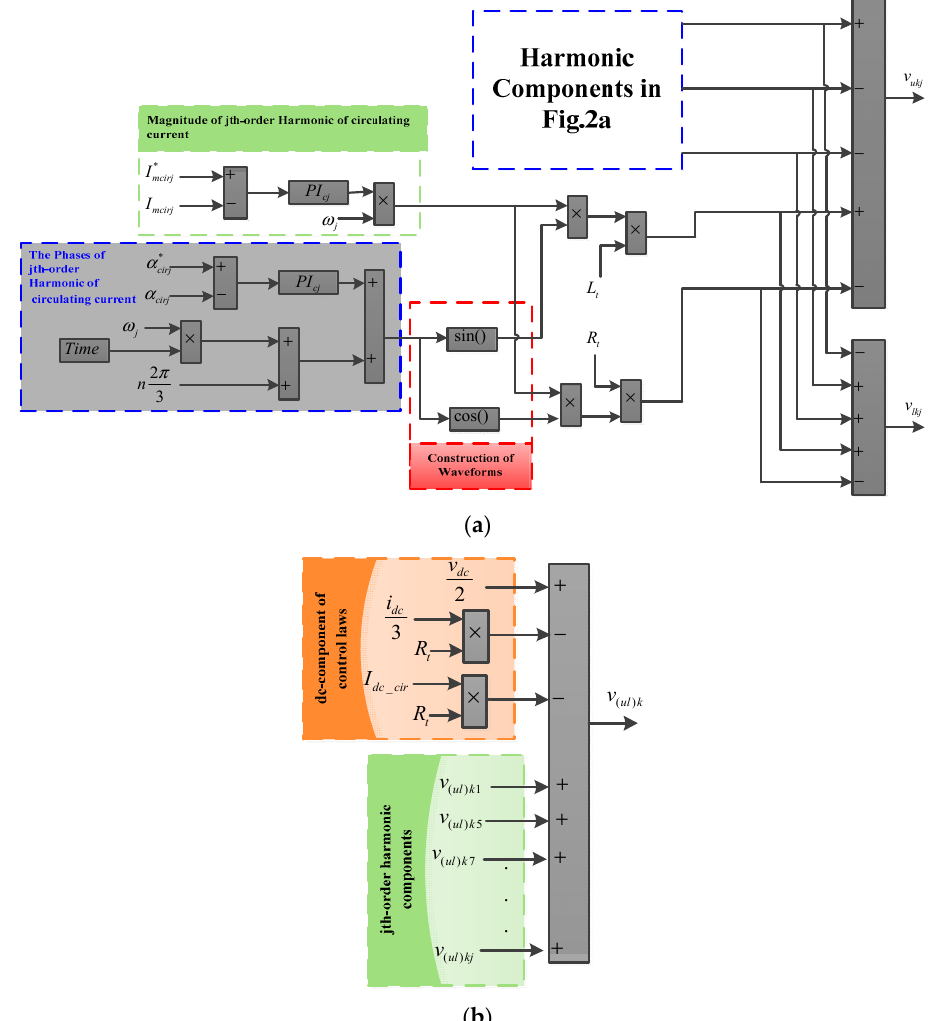
Figure 4. Proposed control strategy under circulating currents with harmonic distortions: ( a ) harmonic components of control laws and ( b ) the control laws.